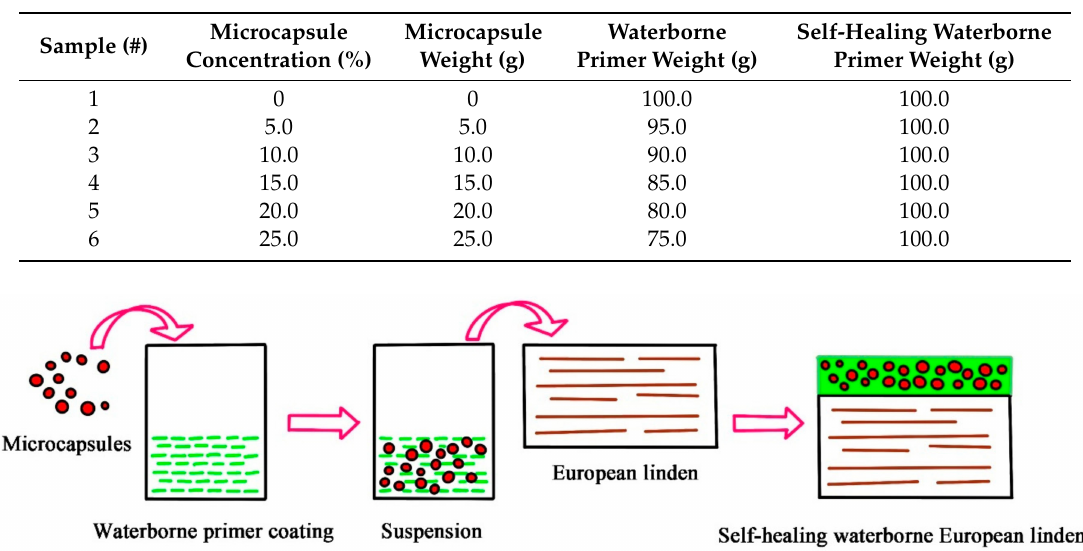
Table 2. Composition of Waterborne Primer with Microcapsules.